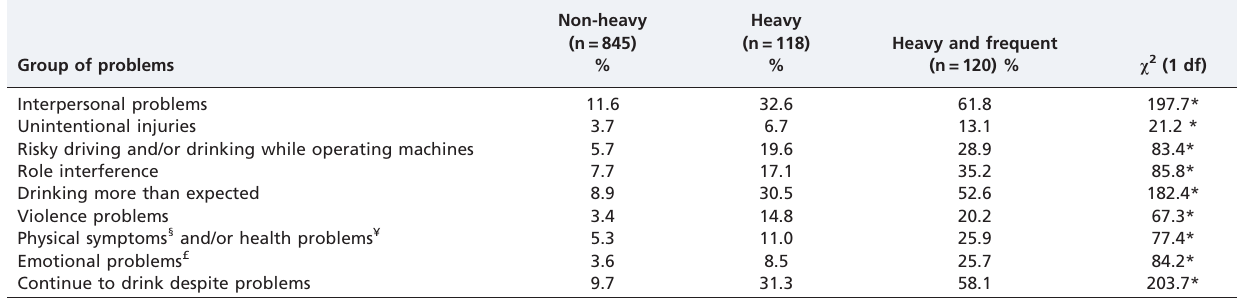
Table 2 - Percentage of alcohol-related problems stratified by drinking pattern. Cochran-Mantel-Haenszel x 2 test-to-test linearity (SP-ECA; n = 1,464).